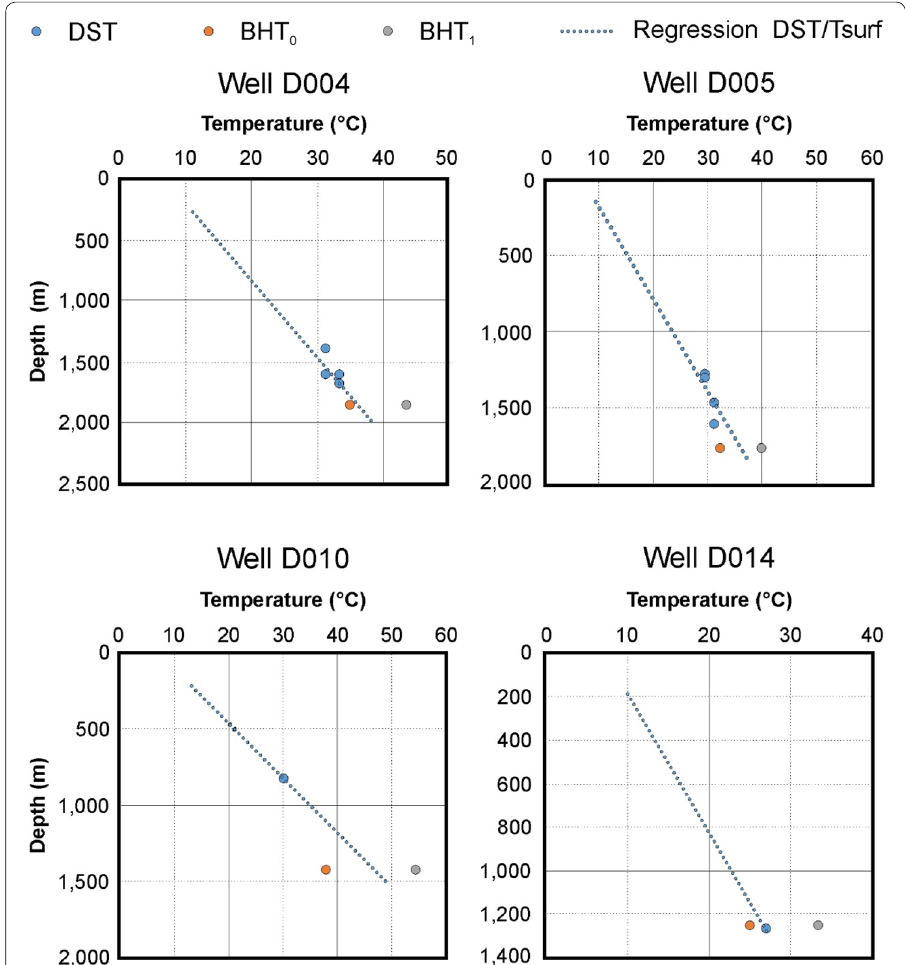
Fig. 10 Comparison of available DST temperature data with uncorrected and corrected BHT data. The regression line was fixed at 0 m depth according to the undisturbed ground